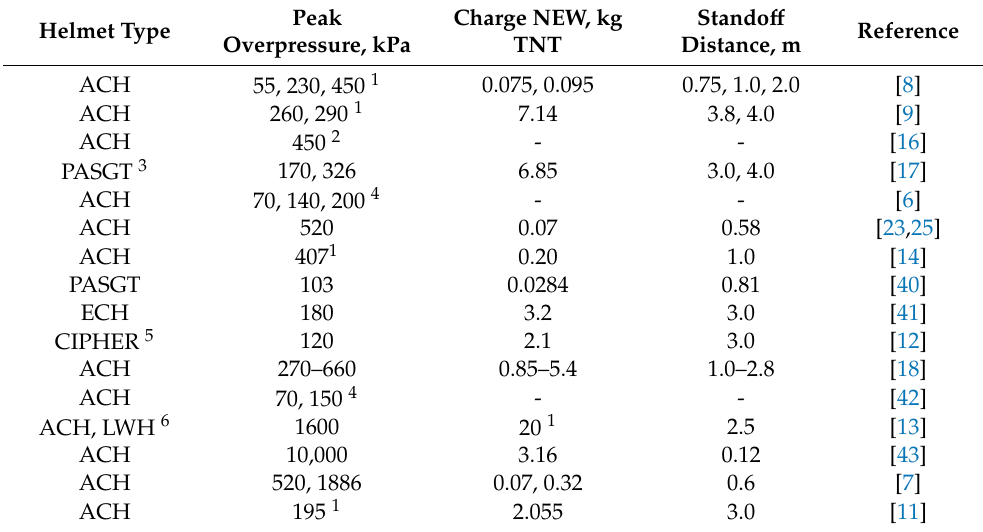
Table 2. The summary of the computational FEM studies which evaluated blast mitigation performance of various combat helmets using high-fidelity human head models. The helmet type, incident peak blast overpressure (reported or calculated) with a corresponding mass of the charge mass (TNT equivalency in kg), and stando ff distance are